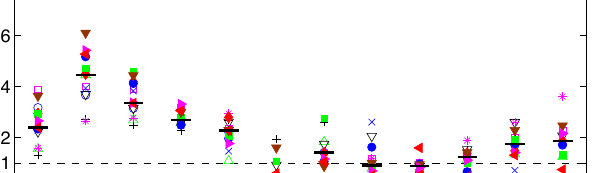
CCCMA (cid:239) CGCM3.1 (T47) CCCMA (cid:239) CGCM3.1 (T63) CNRM (cid:239) CM3 CSIRO (cid:239) MK3.0